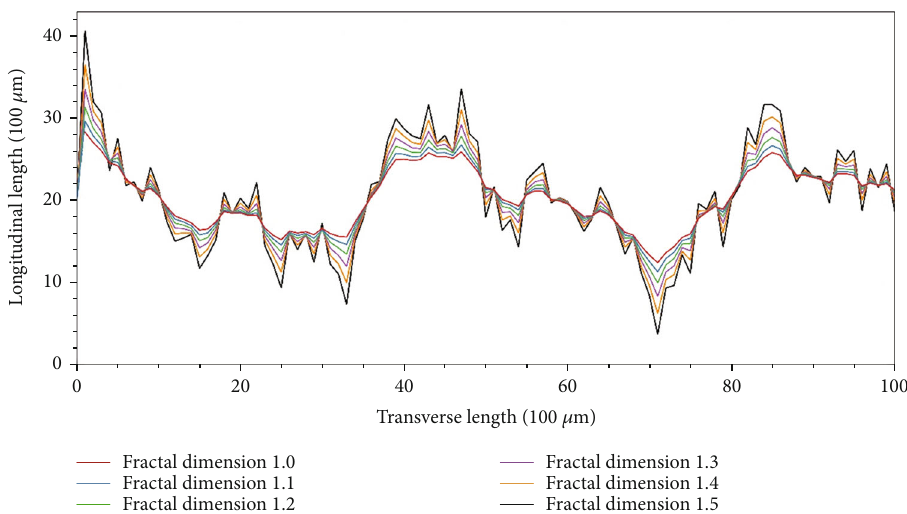
Figure 2: Six sets of two-dimensional fractal curves with fractal dimensions of 1.0 ~